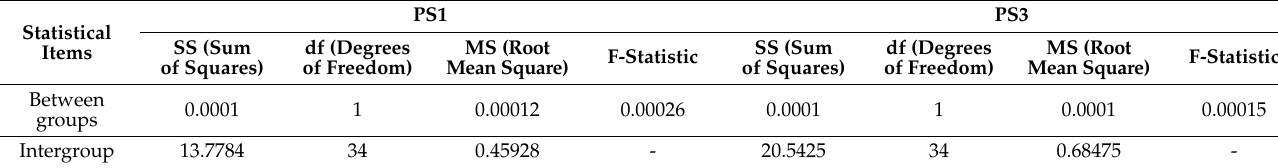
Table 4. Results of one-way